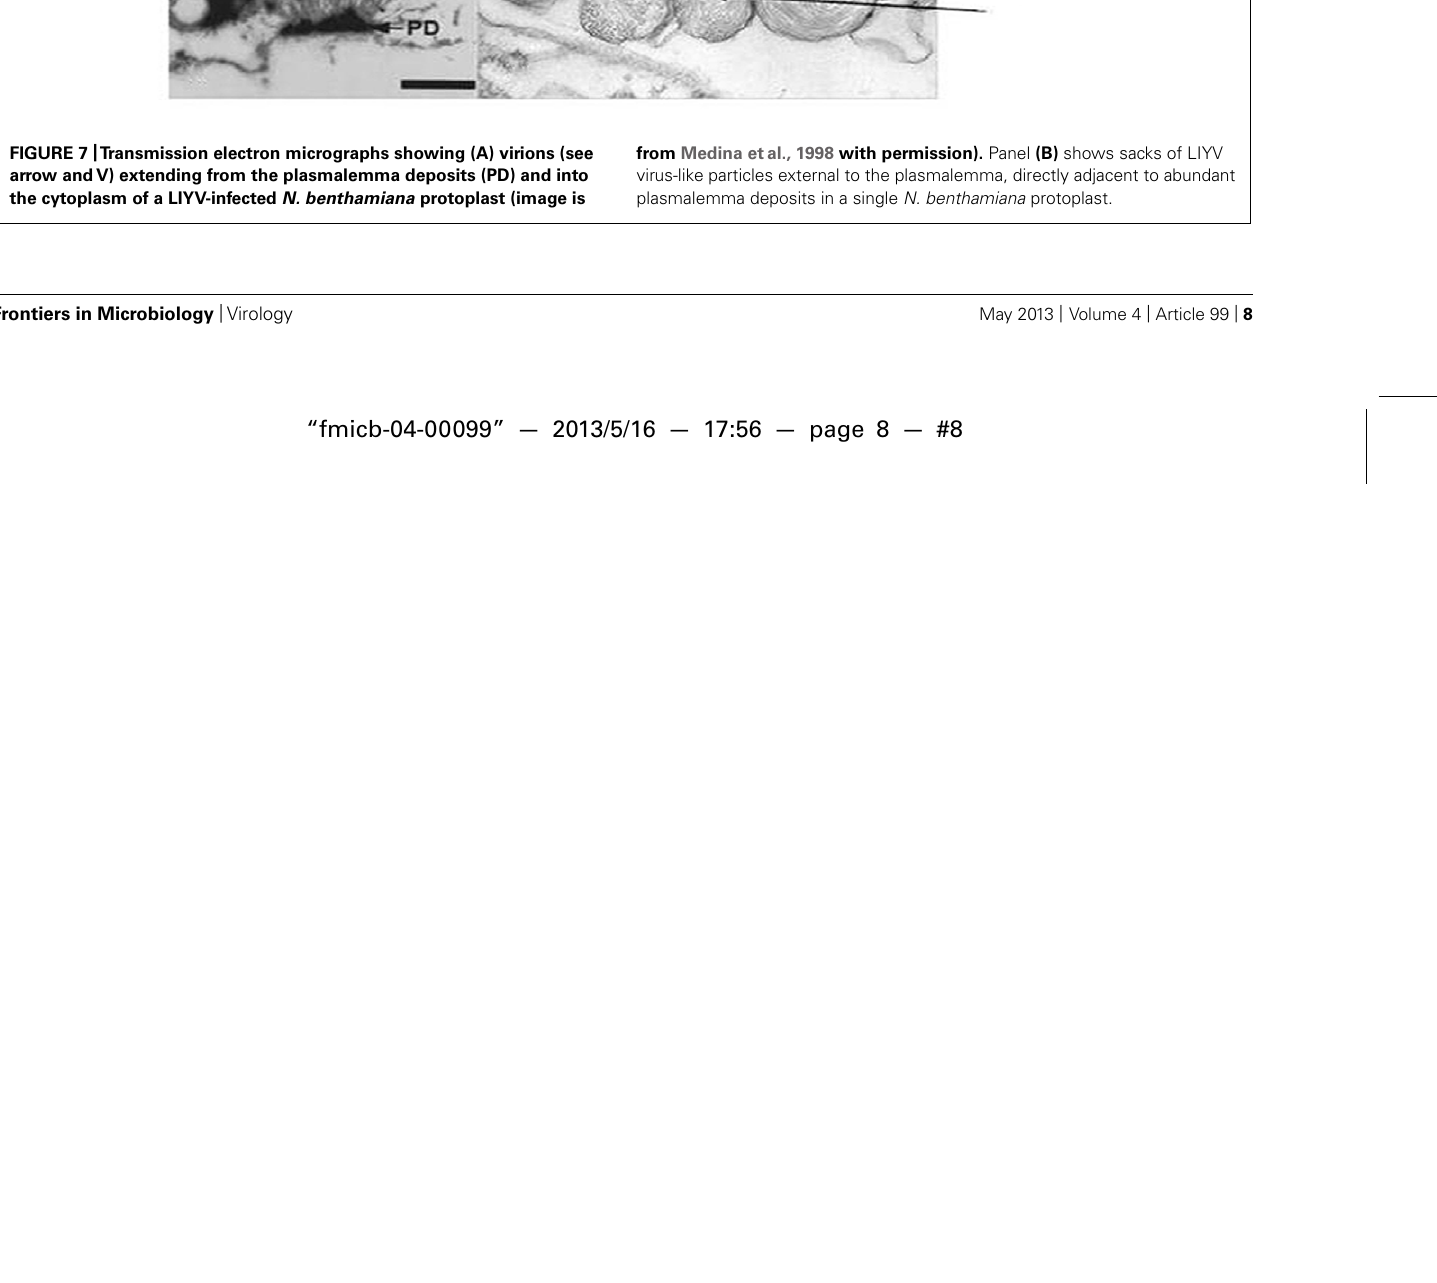
from Medina etal., 1998 with permission). Panel (B) shows sacks of LIYV virus-like particles external to the plasmalemma, directly adjacent to abundant plasmalemma deposits in a single N. benthamiana